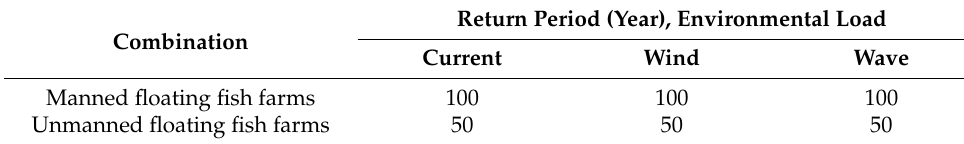
Table 7. ABS’s combinations of environmental loads for floating fish farms.